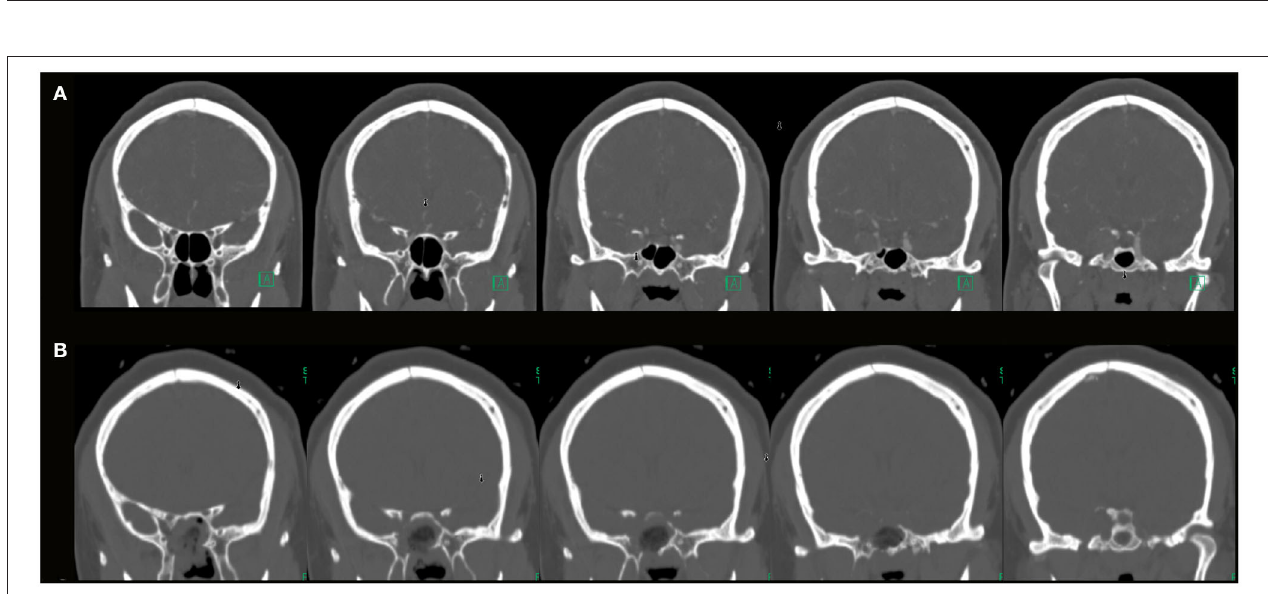
FIGURE 7 | (A) Preoperative coronal CTA images (bone window) of a patient with a right side cavernous sinus meningioma; (B) postoperative coronal CT images (bone window) showing the area of bone decompression on the sella, medial aspect of the superior orbital fissure and cavernous sinus.